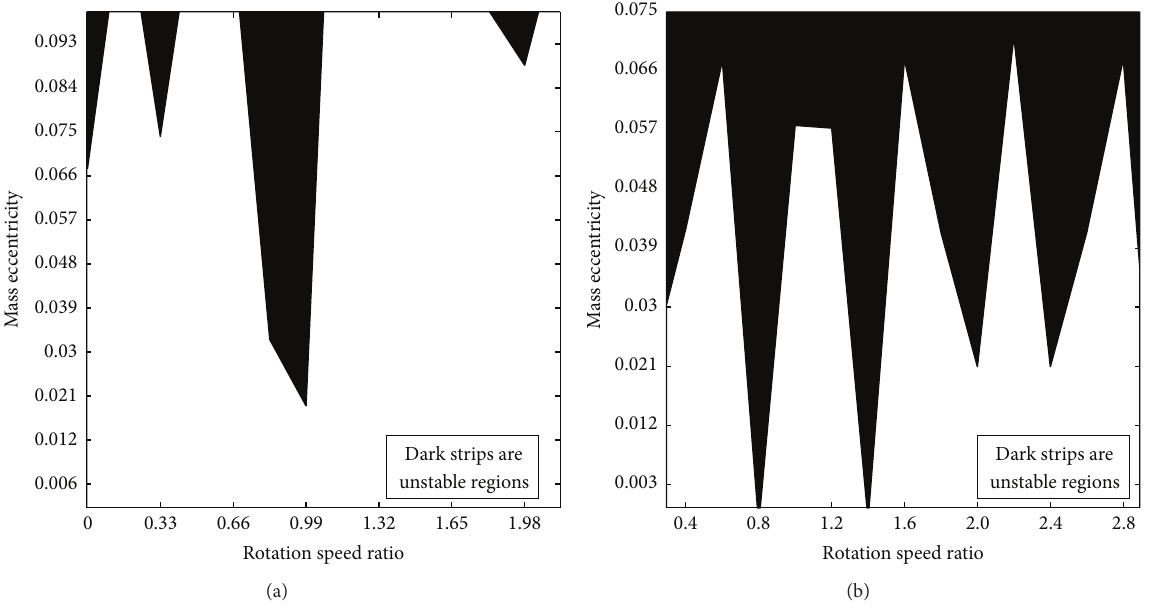
Figure 7: Stability diagrams with respect to the varied mass eccentricity with parameters for the speed up uncracked rotor (the dark zones are unstable regions and the white zones are stable regions) (a) with parameters: 𝑎/𝐷 = 0, unbalance orientation angel 𝛽 = 𝜋/ 2, and damping ratio 𝜁 = 0 . 01; and the cracked rotor (b): crack depth ratio 𝑎/𝐷 = 0 . 45, unbalance orientation angel 𝛽 = 𝜋/ 2, and damping ratio 𝜁 = 0 .